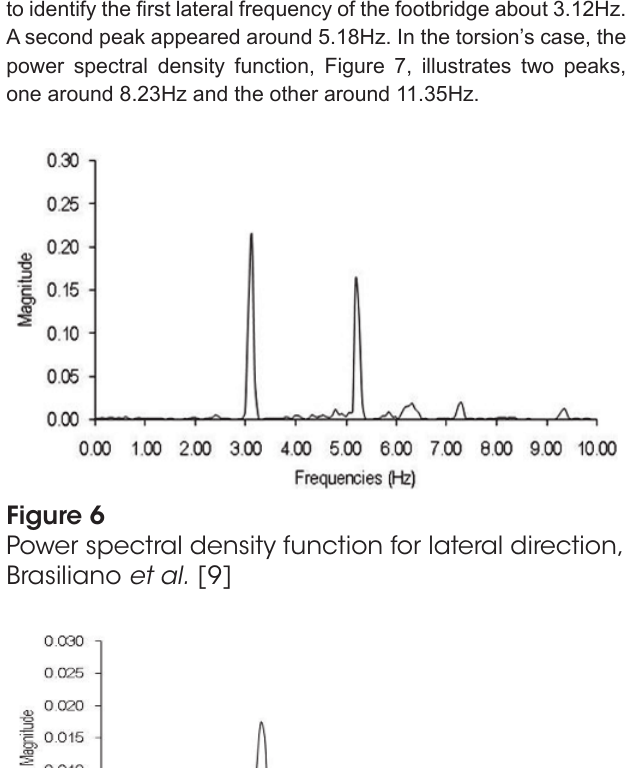
Natural frequencies identified experimentally First set of